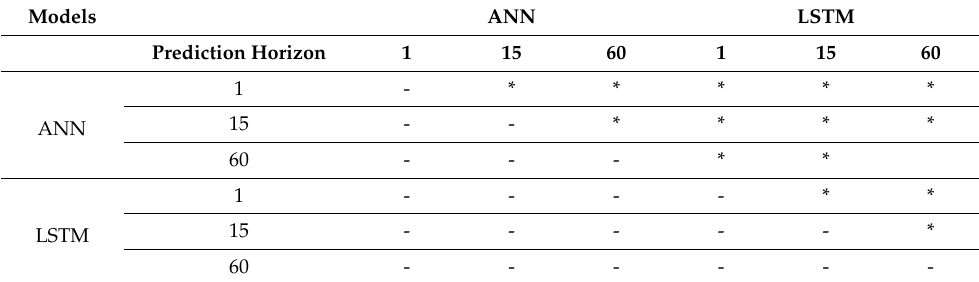
Table 7. Statistical difference in prediction accuracy (nRMSE) by model and horizon.